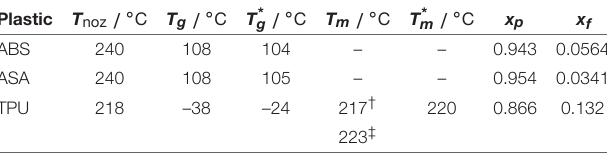
TABLE 1 | Print profiles and thermal characteristics of printing